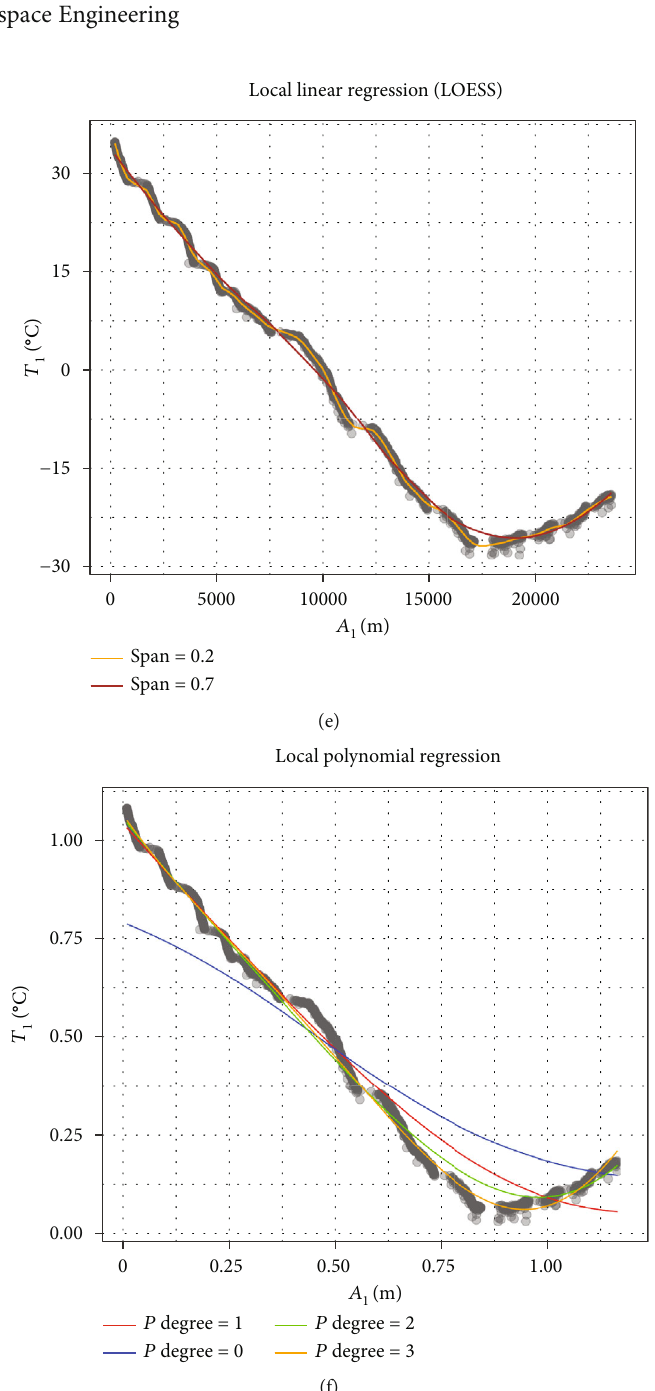
Figure 19: Estimation of di ff erent nonparametric fi ttings for the relationship between the variable T